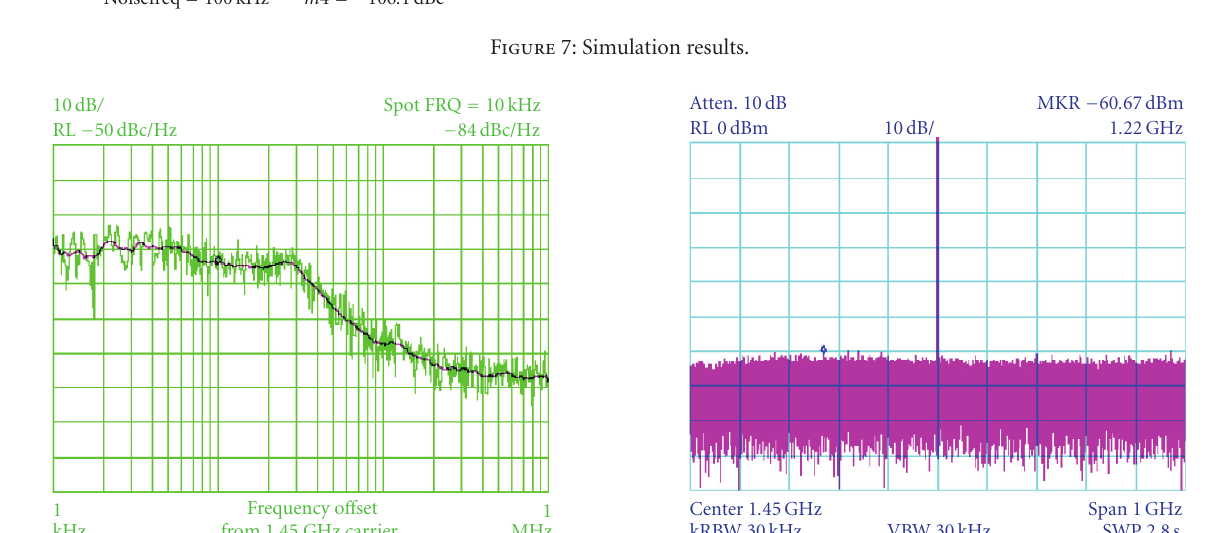
Figure 7: Simulation results.